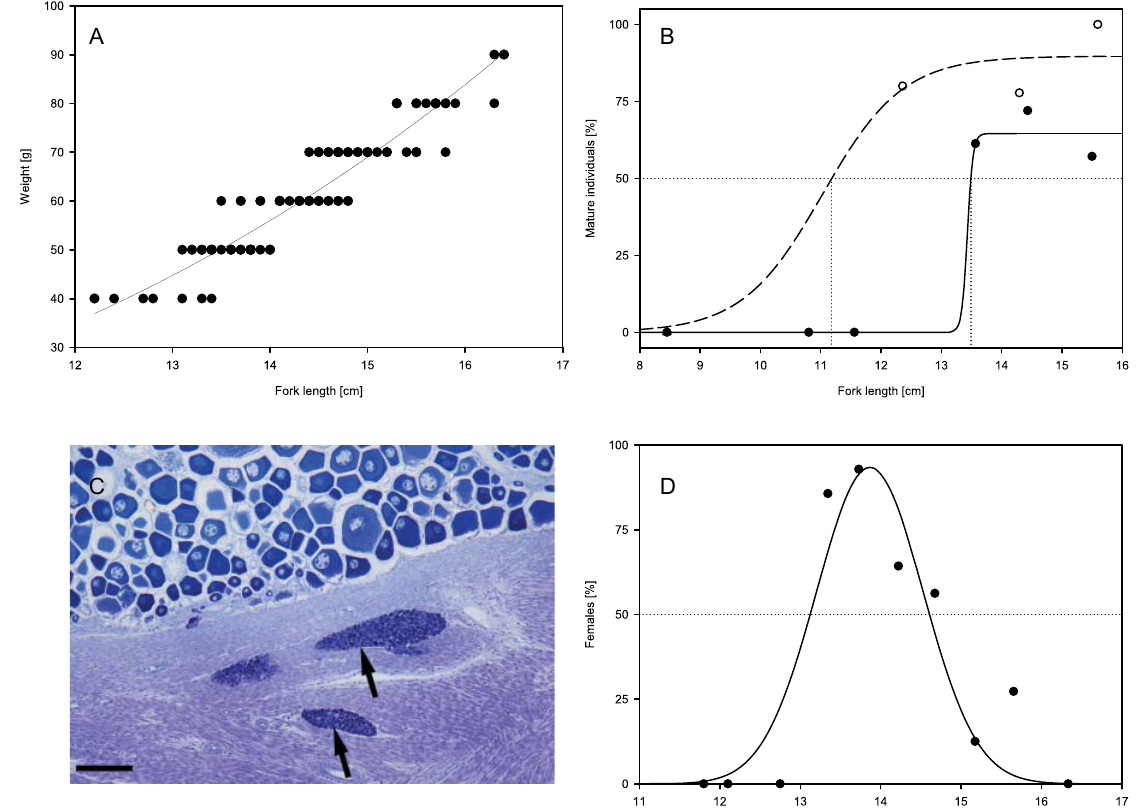
Fig. 2. Scolopsis lineata from the Kamiali Wildlife Management Area, Papua New Guinea: Length–weight relation ( A ); L for males (open circles, dashed line) and females (closed circles, solid line), undifferentiated individuals 50 are represented by triangles ( B ); An ovotestis from a 15.5 cm FL individual, arrows indicate clusters of inactive spermatocysts within the gonad wall, scale bar = 100 μm ( C ); size-specifi c sex ratios for mature individuals (